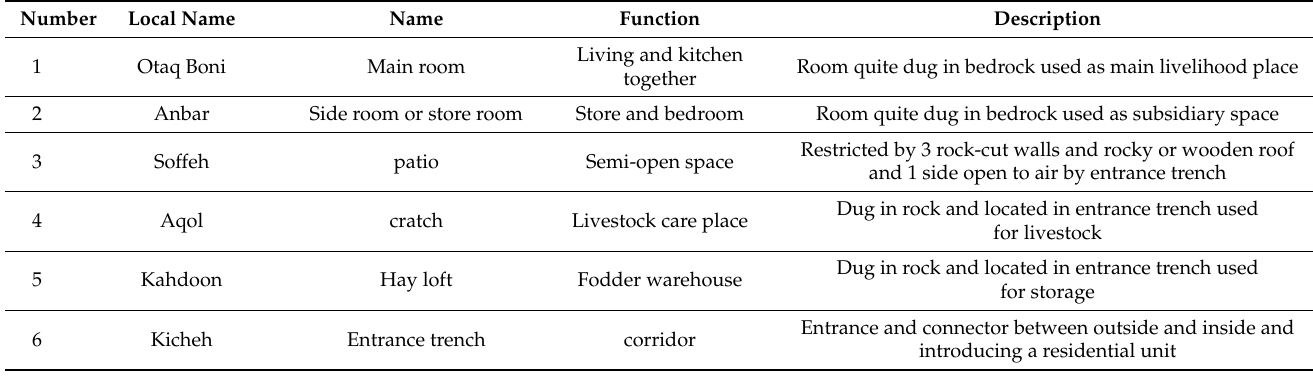
Figure 23. The function of rooms in Maymand’s house architecture. Table 3. The description of the function of rooms in Maymand’s house architecture according to Figure 23.